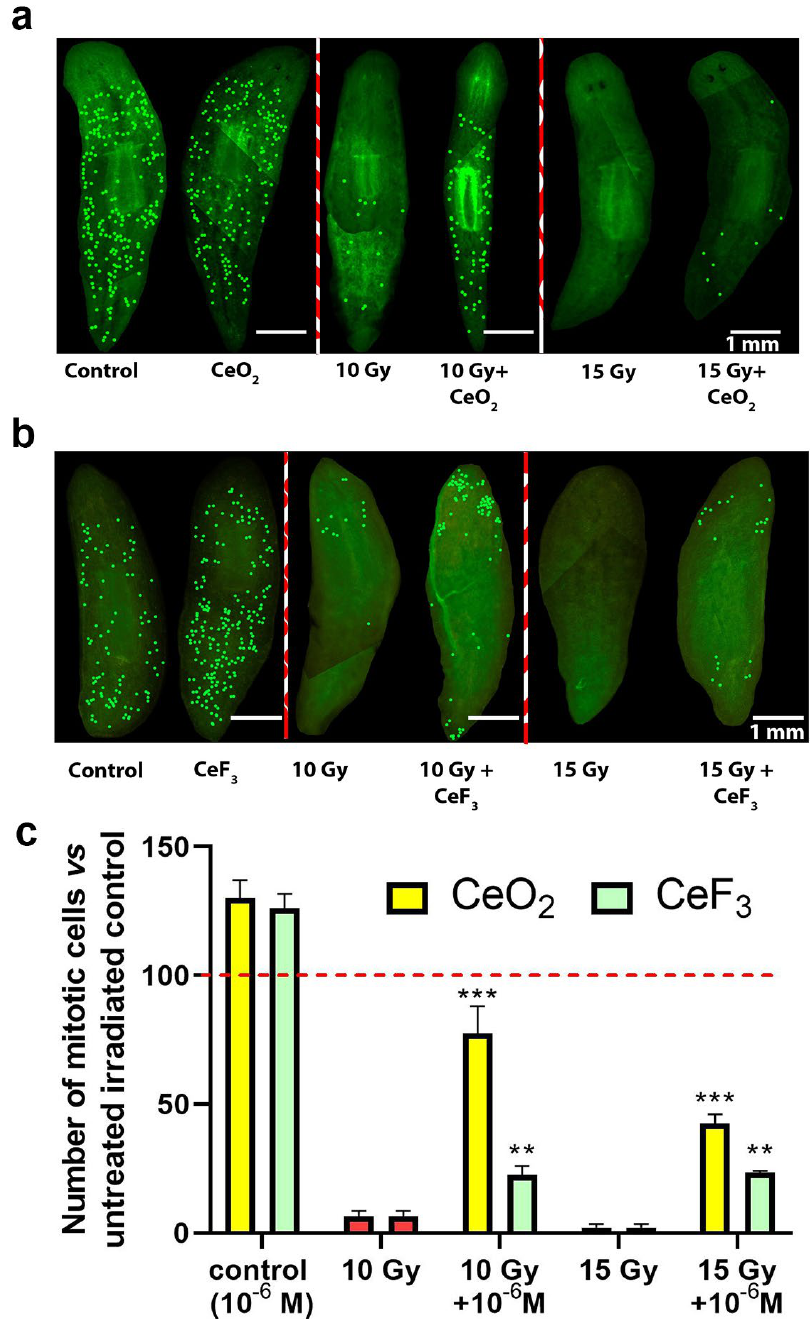
Figure 5. Mitotic activity of regenerating planarians pretreated with CeO 2 and CeF 3 nanoparticles and X-ray irradiated. Photographs of immunostained planarians after X-rays irradiation with CeO 2 ( a ) and cerium fluoride ( b ) nanoparticles. Quantitative analysis of the level of mitotic cells ( c ). This concentration of nanoparticles (10 − 6 M) was chosen as it gave the most pronounced effect. Significance was estimated by one-way analysis of variance (one-way ANOVA). Data are presented as means. Significant statistical difference ** p < 0.001, *** p < 0.05 compared to the untreated control (indicated by the red line).